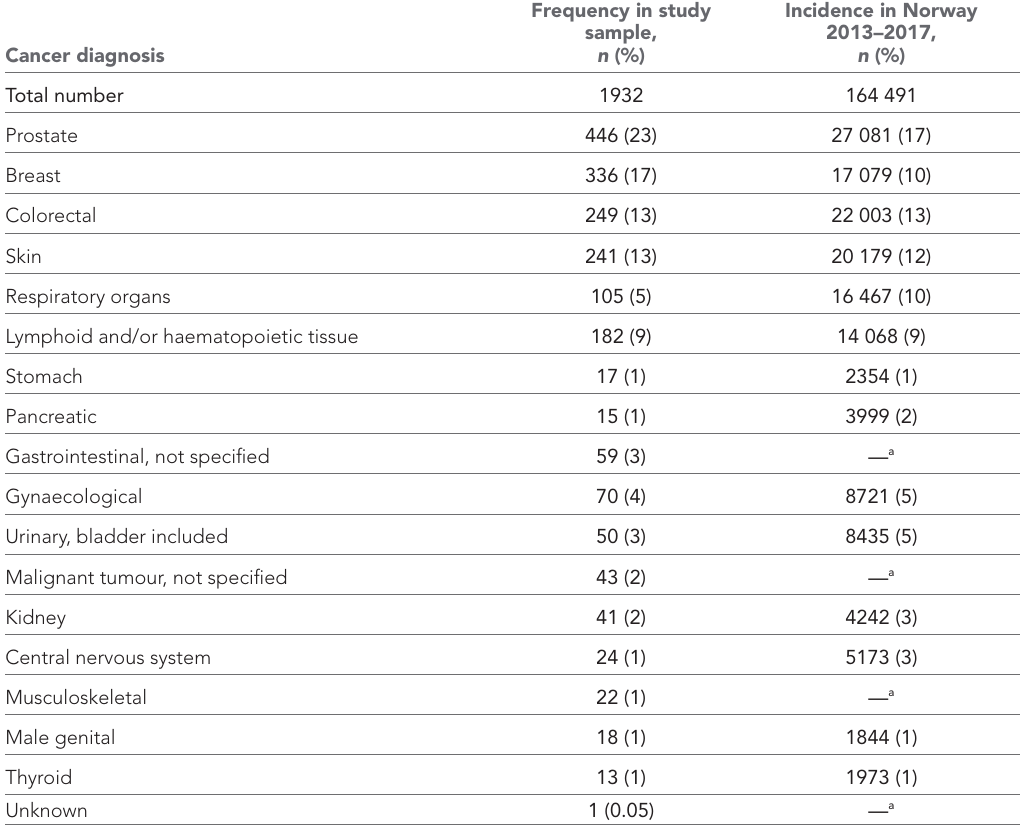
Table 3 Distribution of cancer diagnoses in 1932 patients consulting their GP during a 1-year